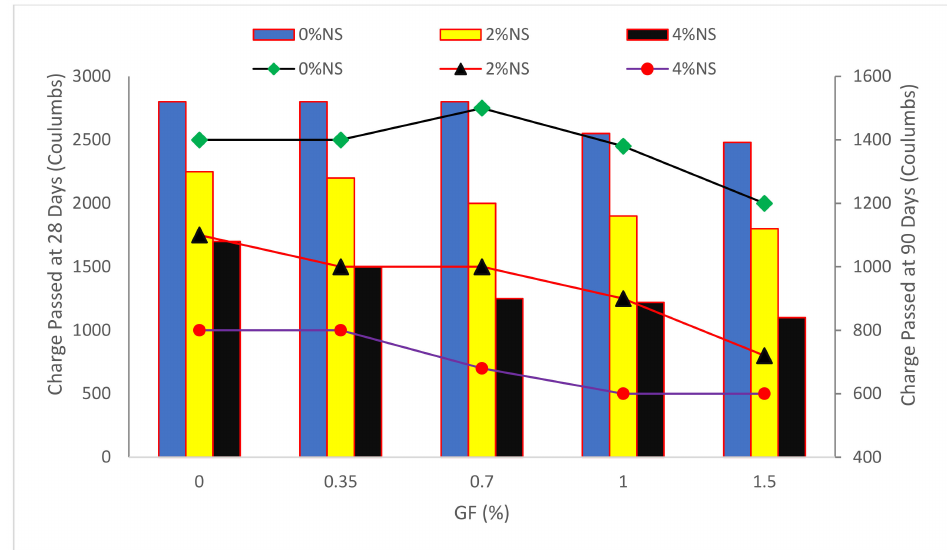
Figure 10. Chloride-Ion Penetration: Data Source